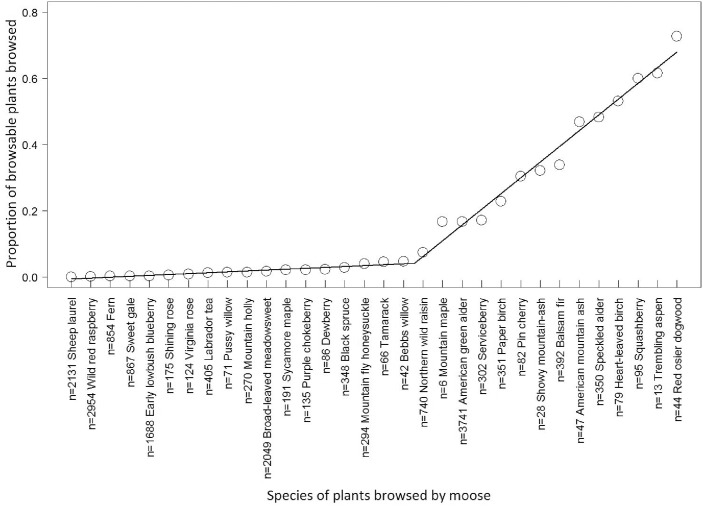
Segmented regression analysis of moose plant preference.Segmented regression analysis used to determine preferred plant species for moose within the entire study. The proportion of browsable plants browsed was determined using plants that were browsed at least once by moose in the entire study and then calculated as (the number of browsed plants of species i/ the total number of plants of species i). The threshold occurs after Bebb’s willow (Salix bebbiana), indicating that all plants from northern wild raisin (Viburnum nudum) through red osier dogwood (Cornus stolonifera) are considered preferred forage species for moose in our study area. The n value before each plant name indicates the total number of individuals in all plots. Equation and R2 for each line segment (line 1: y = 0.0027x−0.0082, R2 = 0.91; line 2: y = 0.0475x−0.8398, R2 = 0.98).